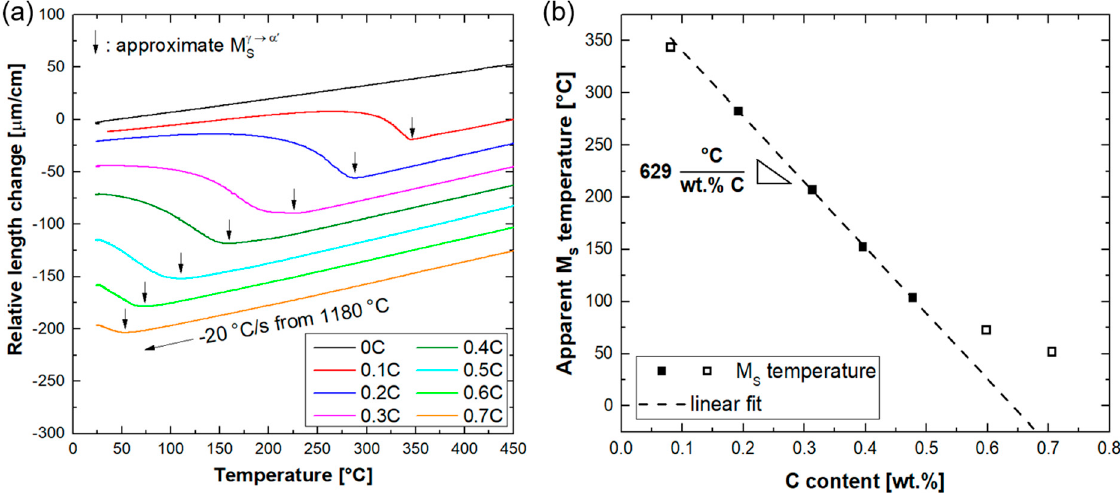
Figure 6. ( a ) Changes in the length of dilatometry specimens quenched from 1180 °C to RT. Except for the 0C alloy, all alloys exhibit remarkable expansions due to martensite formation. The onsets of expansions (M s temperatures) are marked by vertical arrows. For clarity, curves were translated vertically; ( b ) dependence of M s temperature on carbon content. Due to the presence of ferrite in the 0.1C alloy and carbides in 0.6C and 0.7C alloys (open symbols), they were excluded during linear fitting.